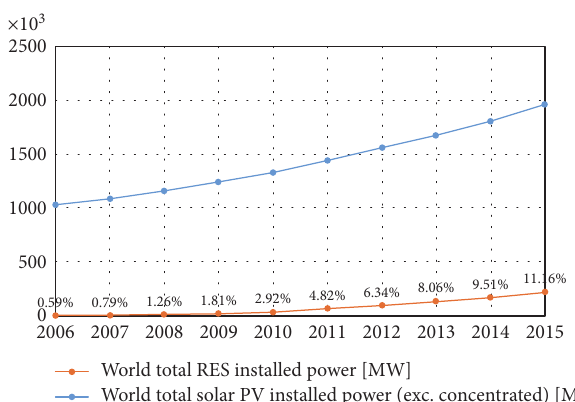
Figure 1: World total RES and solar PV installed power in MW in 2006 – 2015, IRENA statistic 2016.